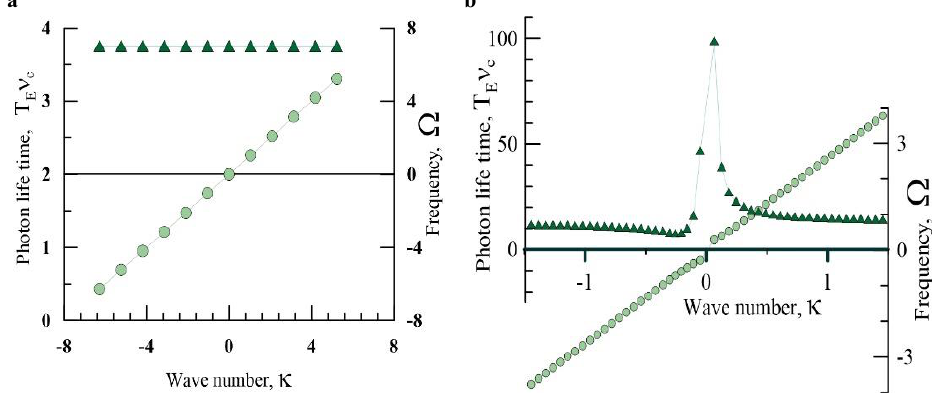
T  , (triangles) and frequencies, ( ) /      , E c 0 c